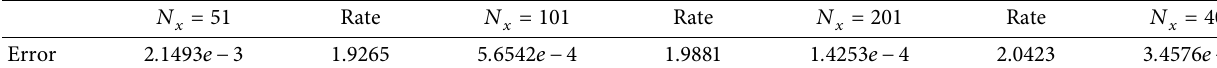
Table 2: l -norm error and temporal convergence rate of numerical solutions. 2